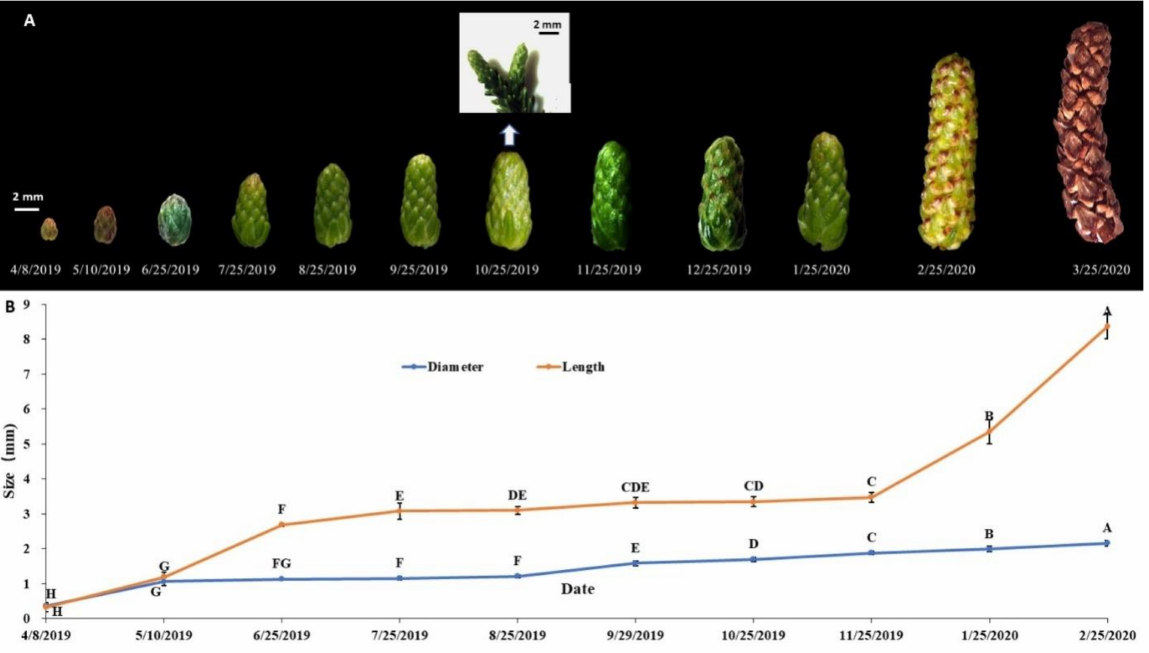
Figure 1. External morphological images ( A ) and size ( B ) of D. pectinatum male cones at different developmental stages. Specimens were collected from Changjiang County, Hainan Province, China. Different letters among length or diameter indicate significant difference at p < 0.05, and n =